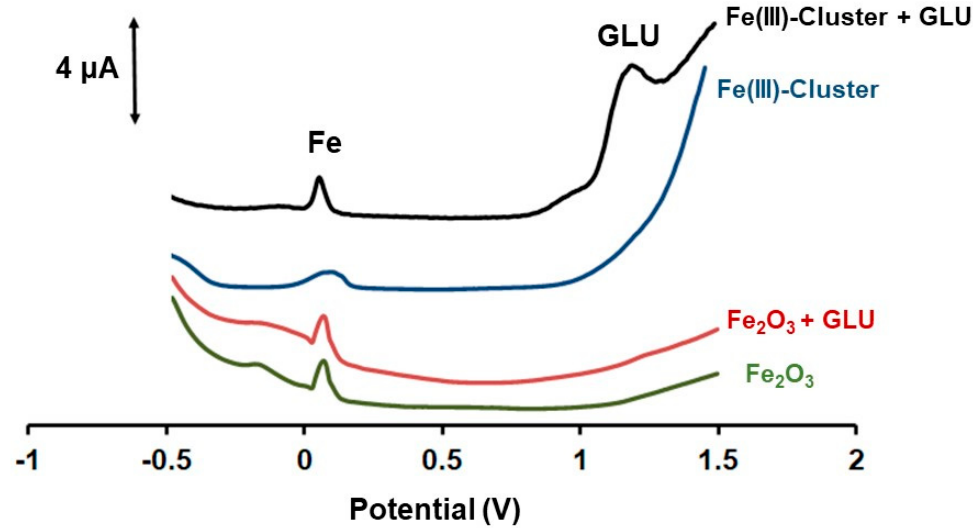
Figure 4. DPV responses of Fe 3 O(PhCO 2 ) 6 (H 2 O) 3 ] · PhCO 2 /3DPE and Fe 3 O 2 /3DPE towards 200 µ mol L − 1 GLU in 0.1 mol L − 1 PB (pH 4). The 3D printed sensor was modified with 6% w / v Fe 3 O(PhCO 2 ) 6 (H 2 O) 3 ] · PhCO 2 (blue and black lines) and with 6% w / v Fe 3 O 2 (red and green lines) (both modifiers as ethanolic mixtures). The reduction potential was − 1.4 V for 360 s for Fe(III)-Cluster, while the reduction time was 0 s in cases of iron oxide.